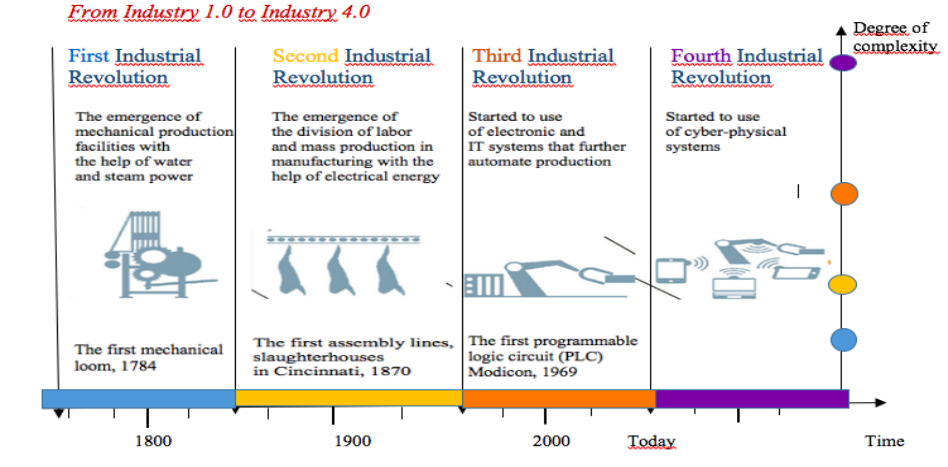
Figure 1: Industrialization Process; Source: Capital, 2013